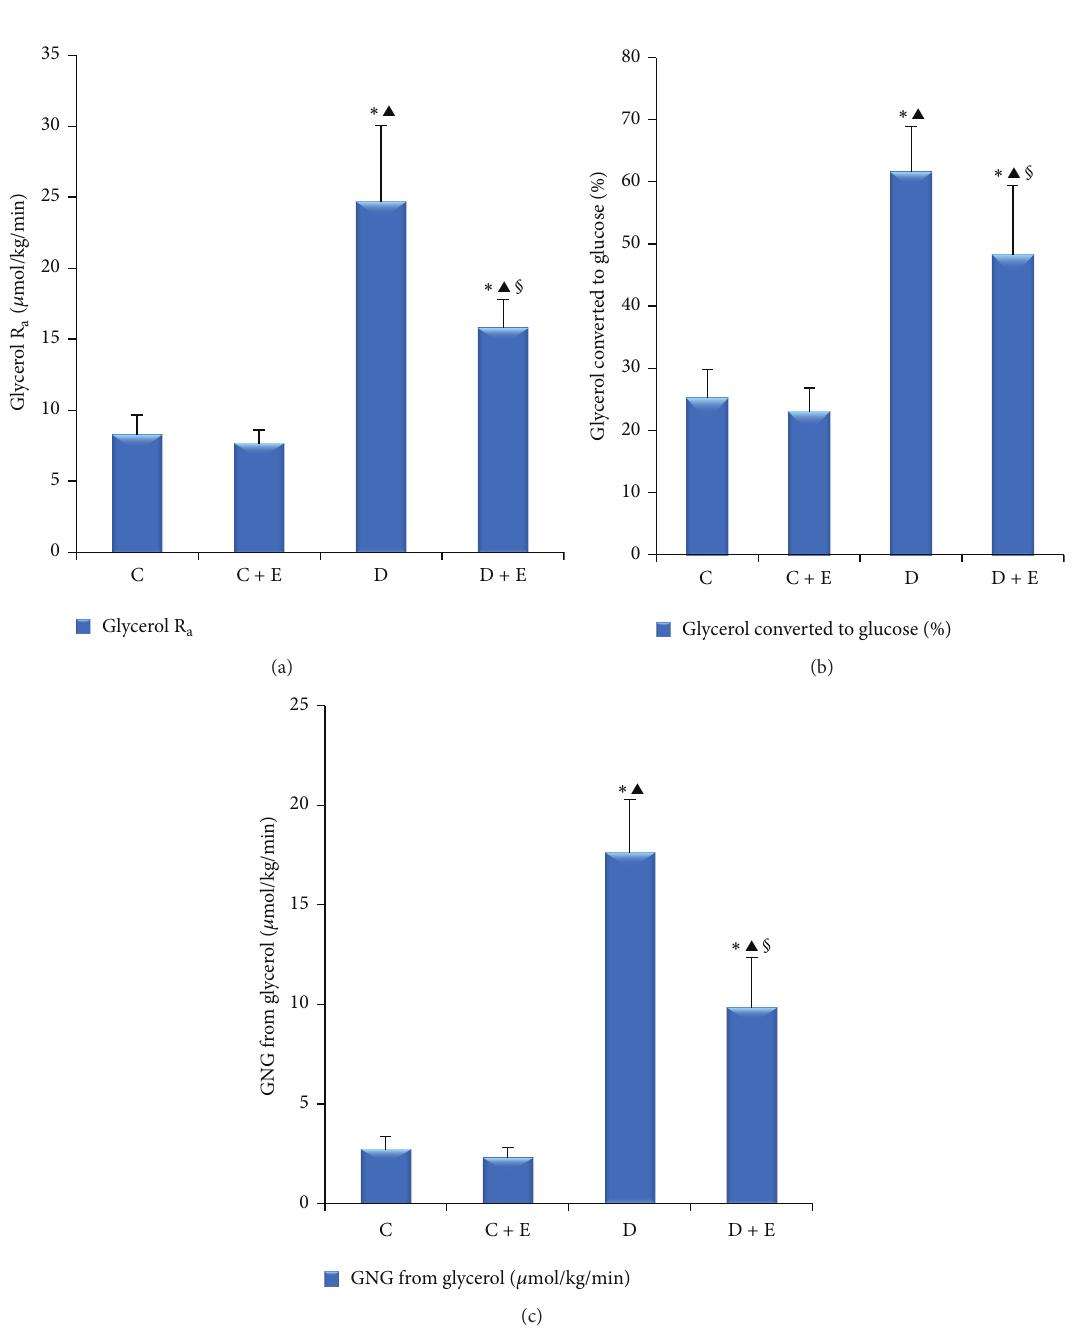
Figure 3: Plasma parameters of glycerol flux and gluconeogenesis. C: nondiabetic, control; C + E: nondiabetic + exenatide; D: diabetic; D means appearance rate; GNG means gluconeogenesis. Data are presented as mean ± SD. ∗ 𝑃 < 0.01 ; # 𝑃 < 0.05 + E: diabetic + exenatide. R a compared with C group. 󳵳 𝑃 < 0.01 compared with C + E group. § 𝑃 < 0.01 compared with D group. Glycerol appearance after an overnight fast was lower ( 𝑃 < 0.01 ) in the D + E group rats than that in the D group rats (a). The gluconeogenesis from glycerol, such as glycerol converted to glucose (%) and gluconeogenesis from glycerol, was clearly lower ( 𝑃 < 0.01 ) in the D + E group rats than that in the D group rats. (b and c). ∗ 𝑃 < 0.01 , # 𝑃 < 0.05 compared with basal. 𝛽 𝑃 < 0.01 , 𝛼 𝑃 < 0.05 compared with C group. 𝜎 𝑃 < 0.01 , 𝛾 𝑃 < 0.05 compared with C + E group. § 𝑃 < 0.01 , 𝜑 𝑃 < 0.05 compared with D